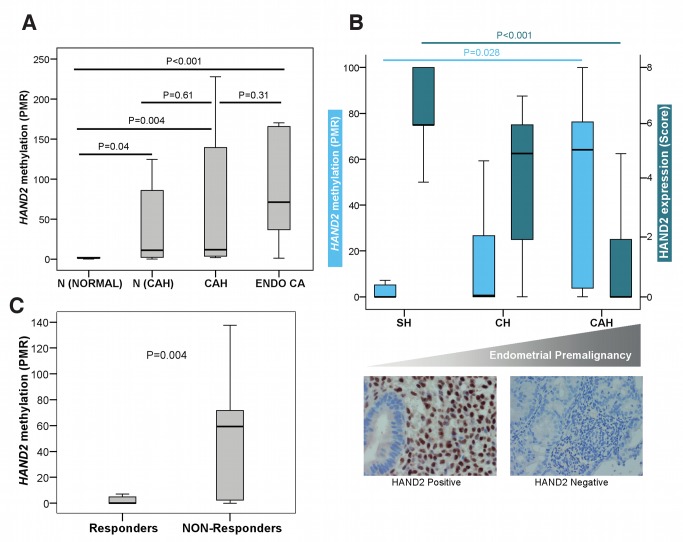

HAND2 methylation in human endometrial carcinogenesis.(A) Boxplot comparing the differences in the HAND2 MethyLight PMR profiles in endometrial samples from women without any endometrial pathology (N [Normal], n = 10), in normal endometrium from women with CAH (N [CAH], n = 7), in CAH samples (CAH, n = 8), and in endometrioid endometrial cancer samples (Endo CA, n = 12). (B) Boxplots (top panel) comparing DNAme (MethyLight) and HAND2 protein expression (immunohistochemistry quantified by means of the Allred Score) in three different endometrial conditions with increasing potential for malignant transformation (simple hyperplasia [SH], n = 17; complex hyperplasia [CH], n = 10; CAH, n = 7). The lower panel gives an example of the corresponding HAND2 nuclear protein expression in stromal cells in simple hyperplasia compared to loss of stromal expression in CAH. (C) Boxplot comparing the differences in the HAND2 MethyLight PMR profiles in endometrial cancer from patients treated with progesterone according to whether they had clinically responded (n = 29) or were non-responsive (n = 13) to treatment. All p-values were obtained from the two-sided Wilcoxon rank sum test. Boxes are median (interquartile range), and whiskers indicate range.